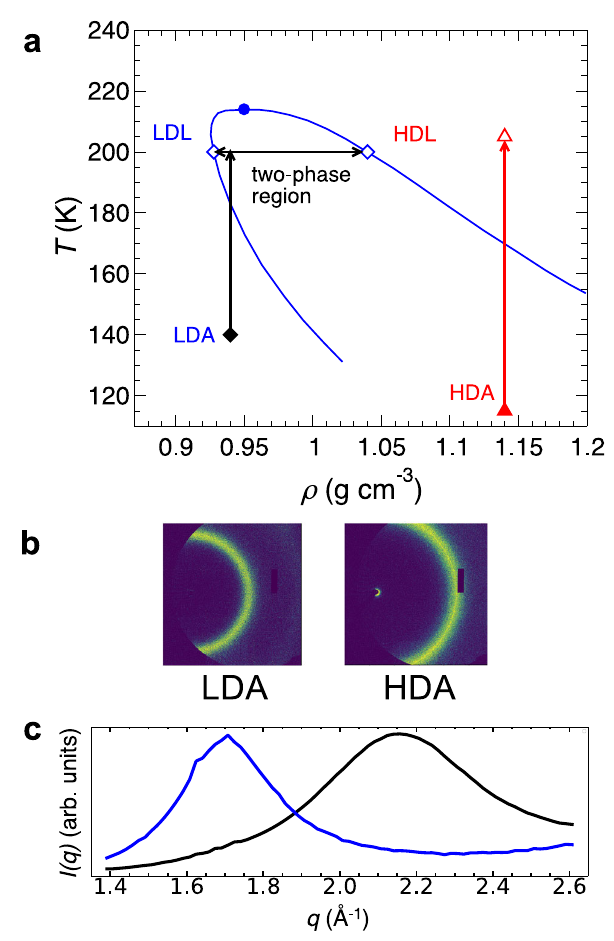
Fig. 2 | Isochoric heating of LDA to access the LDL – HDL coexistence region. a The blue curve is the binodal predicted from thermodynamic modeling in ref. 11 , with the corresponding critical point marked by the fi lled circle. The red arrow correspondstoanisochoricheatingpathway,ofthekindexploredinref. 8 ,inwhich HDA ( fi lled triangle) is heated to HDL (open triangle). The vertical black arrow illustrates the isochoric heating pathway explored here, in which LDA ( fi lled dia- mond) is heated to a liquid state inside the two-phase region of the binodal. This state then phase separates into LDL and HDL components (horizontal arrows). Open diamonds locate the coexistence densities of LDL and HDL at 200 K as determined by the binodal. b , c Characteristic x-ray scattering intensities for LDA andHDAasobserved( b )onthe2Dexperimentaldetectorand ( c )as I ( q )scattering intensitycurvesasafunctionofwavenumber q .TheLDAx-raydatashownin( b , c ) is for the LDA sample prior to IR heating. The HDA x-ray data in ( b , c ) is for a HDA sample asreported in ref. 8 . I ( q ) for LDAand HDA is nearlyidenticalto thatforLDL and HDL, respectively 8,30